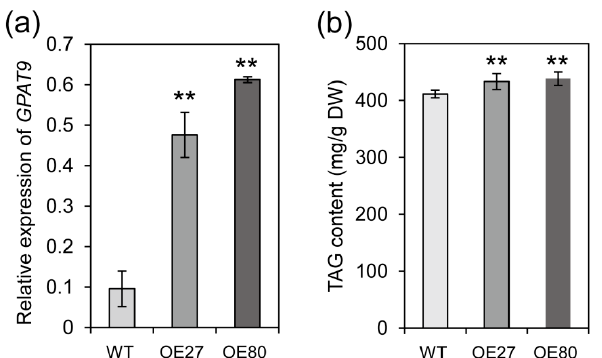
Figure 9. Overexpression of BnGPAT9 enhanced oil accumulation in seeds. ( a ) The BnGPAT9 expression level in transgenic plants confirmed by real-time PCR with β -Actin as an internal standard. Values are means ± SD ( n = 3 separated samples). ( b ) Oil content of seeds of GPAT9 -OE and WT plants. Seeds were collected from plants grown in field at the mature stage. The oil content of seeds was analyzed by GC after methylation. Values are means ± SD ( n = 4). ** denote significance at p < 0.01 compared with WT based on Student’s t test.